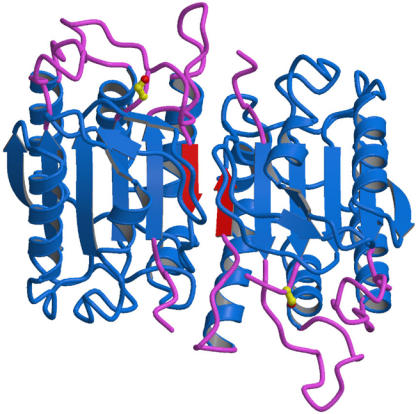
Experiments with artificially joined molecules of caspase 9—which normally exists as monomers (above)—suggest that caspase 9 can't activate cell death pathways by dimerization alone